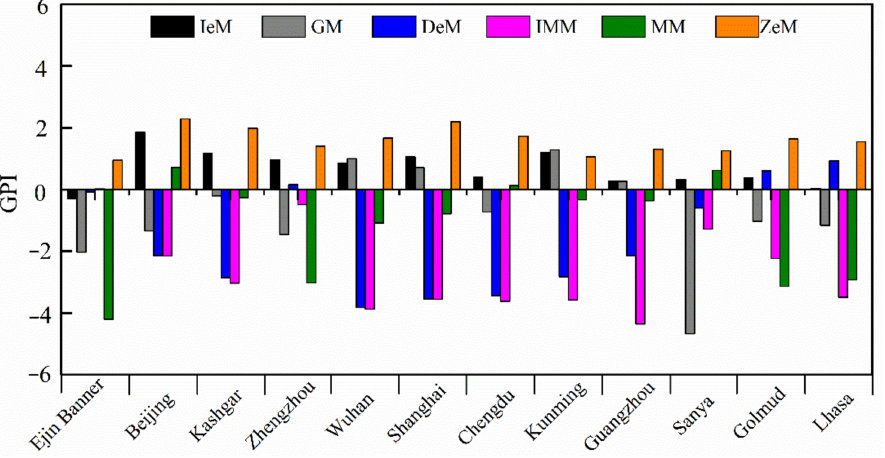
Figure 6. GPI values for the six models at 12 selected